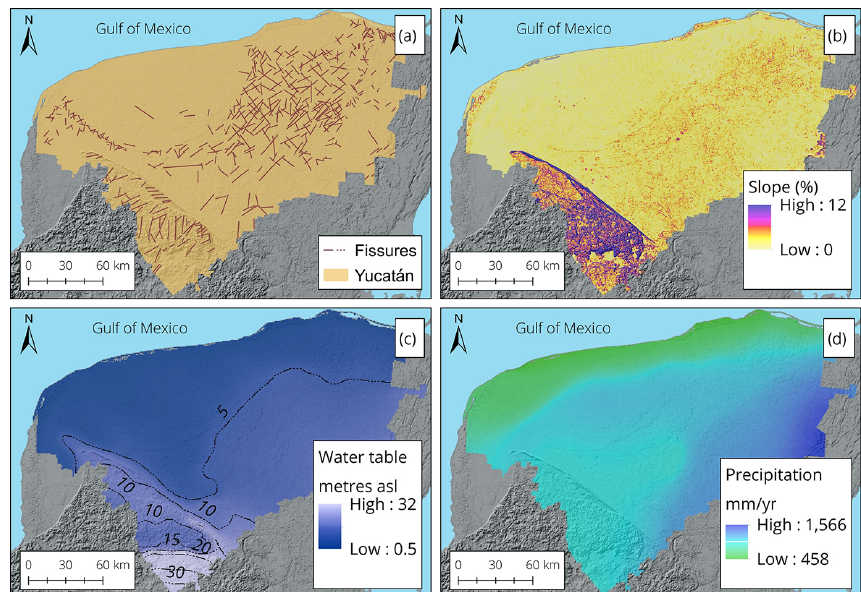
Figure A1. Regional characteristics of the Yucatán karst. (a) Major fissures. (b) The nearly flat conditions of the central plain. (c) The shallow water tables for most of the state. (d) The spatial variability in precipitation. Fissuring map generated from geological datasets from INEGI (1984). Slope map generated from the digital elevation model ASTER GDEM (Advanced Spaceborne Thermal Emission and Reflection Radiometer Global Digital Elevation Model) version 3, at a resolution of 30m, from NASA, METI, AIST, Japan Spacesystems and US/Japan ASTER Science Team (2019). Water table elevation map generated from digitalized contour maps from SARH (1989). Precipitation map generated from precipitation data from the CLICOM web platform (SMN,